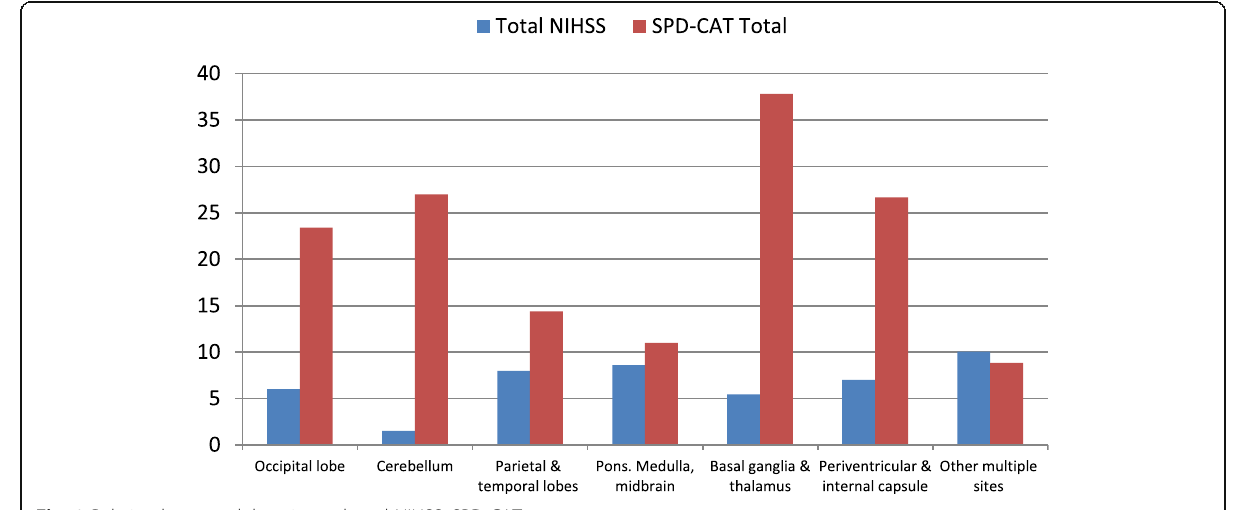
Fig. 9 Relation between lobar site and total NIHSS, SPD-CAT